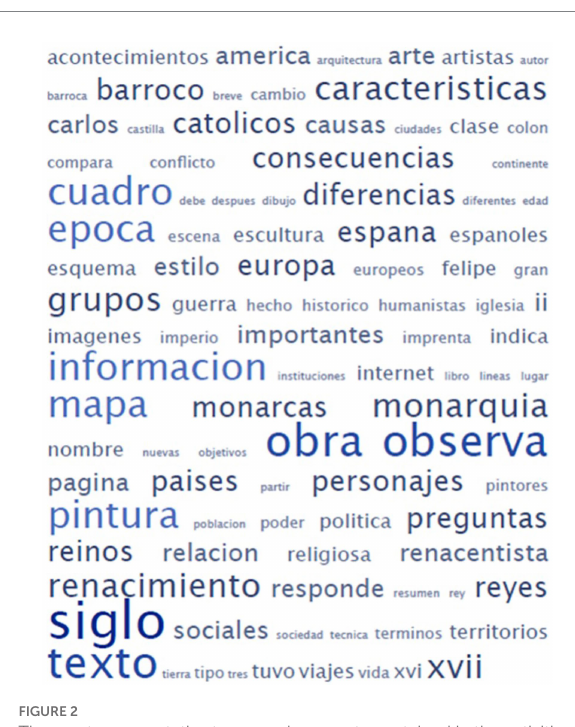
FIGURE 2 The most representative terms and concepts contained in the activities of the selected textbooks (2nd year of secondary